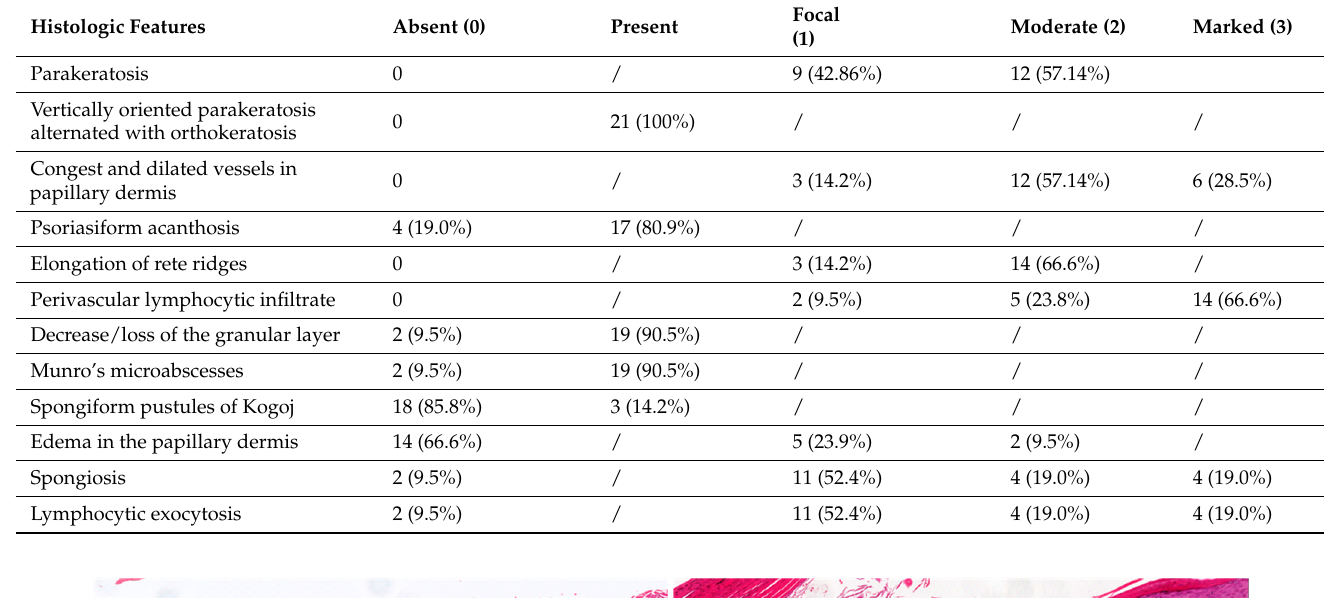
Table 1. Histologic features from our series.